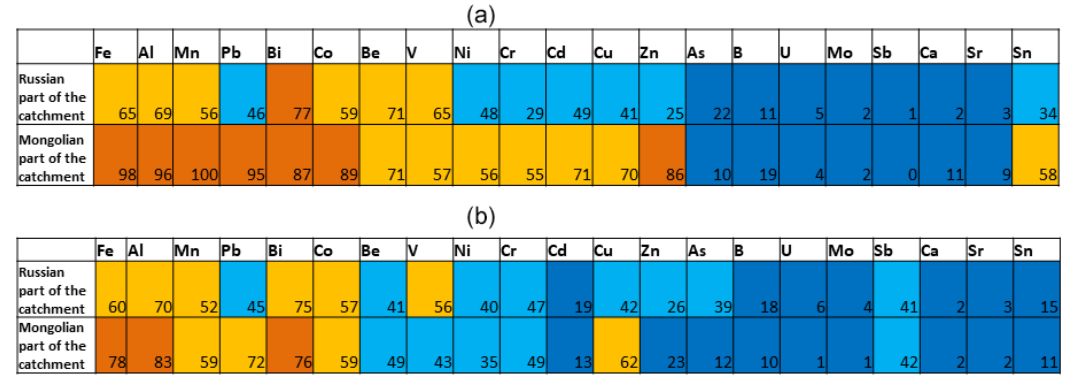
Table 2. Hydrogeochemical signature of a large river system – Selenga River case study. The figure represents metal(loid) partitioning (median values) in the Selenga River basin in the upper (Mongolian) and downstream (Russian) parts between 20 July and 10 August 2011 under dominant high-water (a) and between 7 June and 10 July 2012 under dominant low-water conditions. Dark orange fill corresponds to the share of suspended forms of elements > 75% (green), light orange to 75%–50%, light blue to 50%–25%, and dark blue to < 25%. The figure indicates that in the large river system some metals are mostly found in dissolved form (84%–96% of Mo, U, B, and Sb on average), whereas many others predominantly existed in suspension (66%–87% of Al, Fe, Mn, Pb, Co, and Bi). A consistently increasing share of metals in suspended particulate modes (about 2–6 times) is observed under high-discharge conditions. For details and other hydrological seasons, see Kasimov et al.